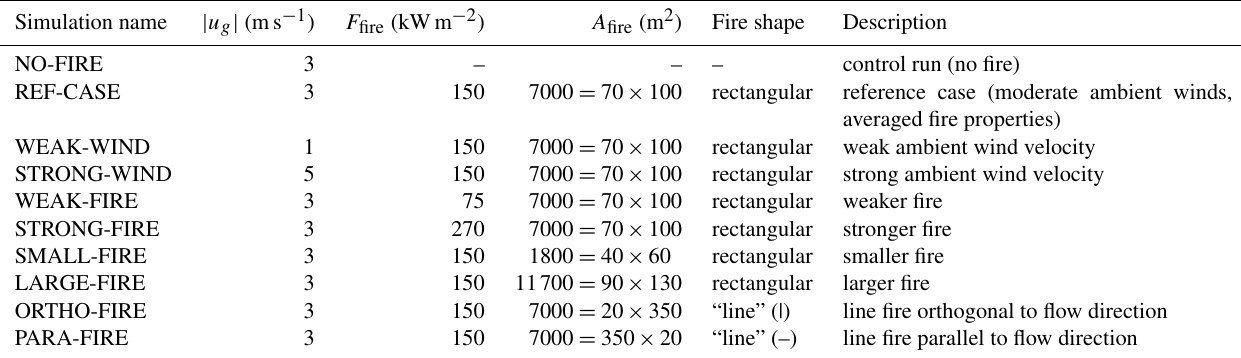
Table 1. Overview of the case